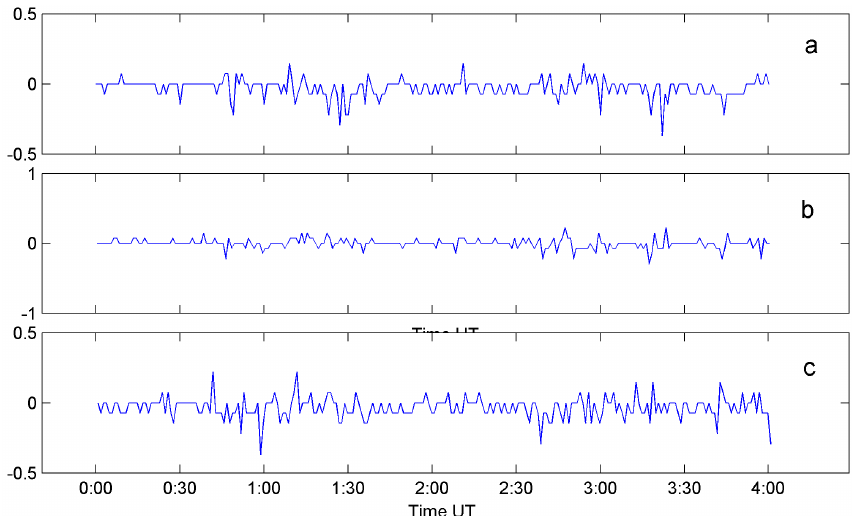
Fig. 4. The temporal variation of DFS of one-hop wave reflected by Es recorded by the Suzhou receiver at (a) 6.6, (b) 8.2 and (c) 10.6MHz on 23 July 2009.